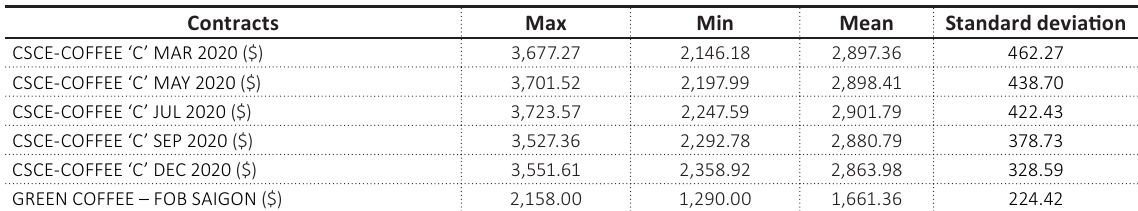
Table 5. Statistics of data on futures prices and spot prices of Arabica coffee Source: Authors’ calculation based on data collected from Thomson Reuters